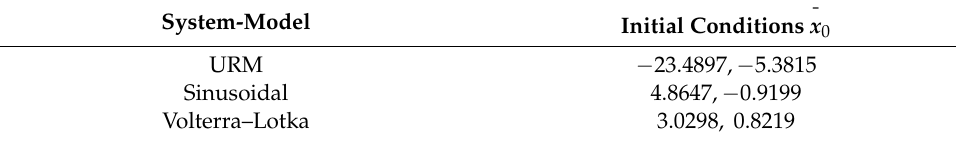
Table 6. The initial simulation